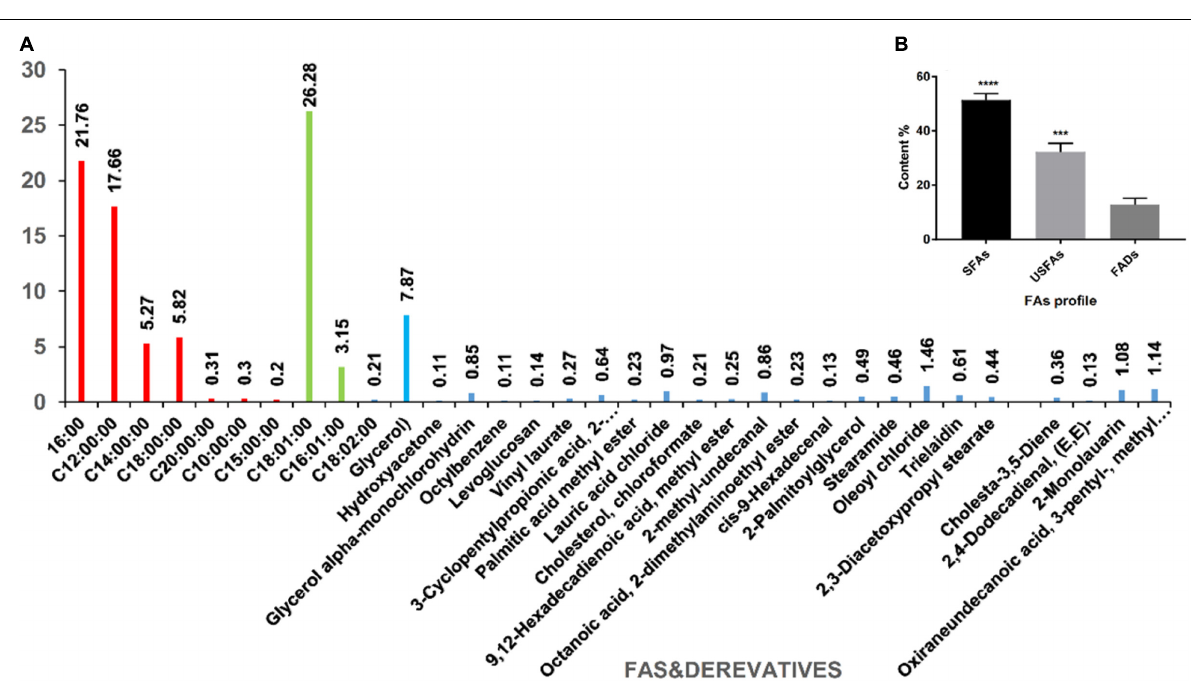
FIGURE 7 | The composition of AWME3 extracted from H. illucens larvae fat under optimal conditions. (A) The percentages and the identity of the AWME3 chemical compounds detected by GC-MS analysis using the NIST-08 library; (B) The FAs profile that includes SFAs, USFAs, and FAs derivatives (FADs) statistically analyzed (*** p = 0.0002, **** p < 0.0001) by one-way